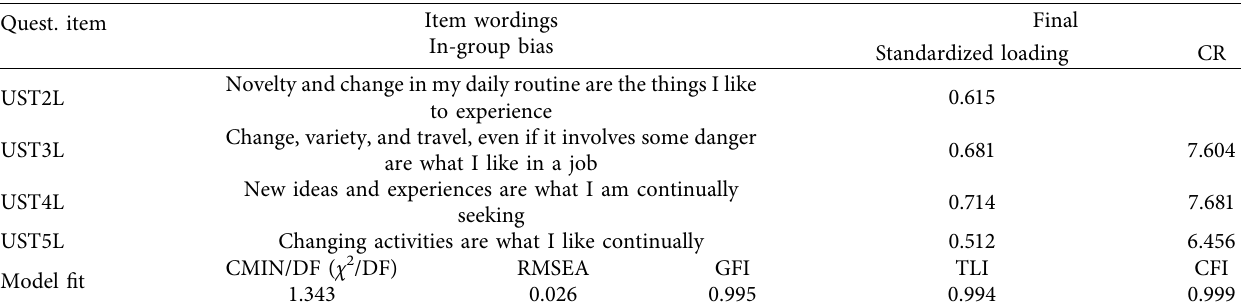
Table 5: Model fit summary (confirmatory factor analysis of uniqueness-seeking